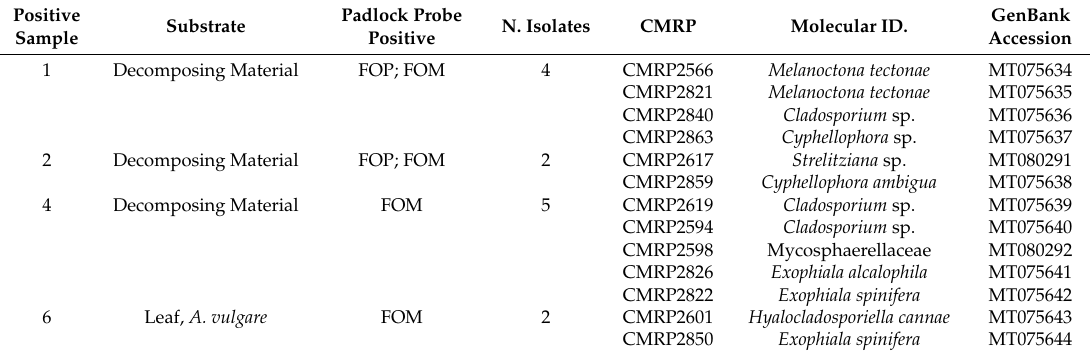
Table 2. Fungi isolates from positive samples by RCA padlock probes (FOP and FOM).